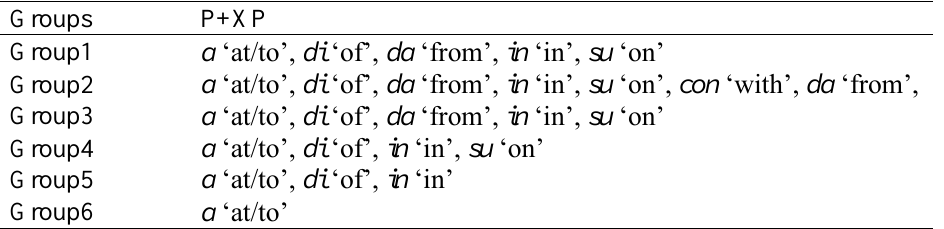
Table 9. Omission of prepositions in the P+XP context across MLU Groups Groups